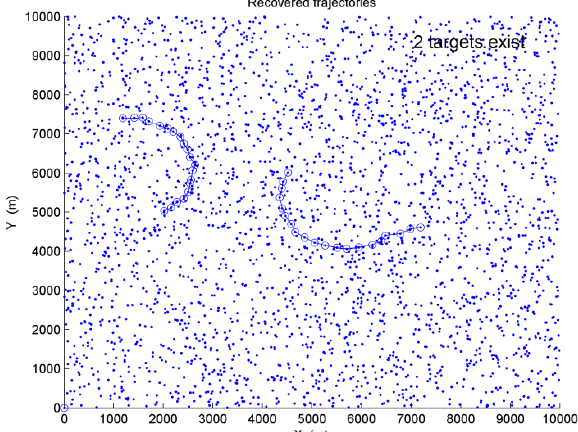
Figure 5. Recovered trajectories and estimated target